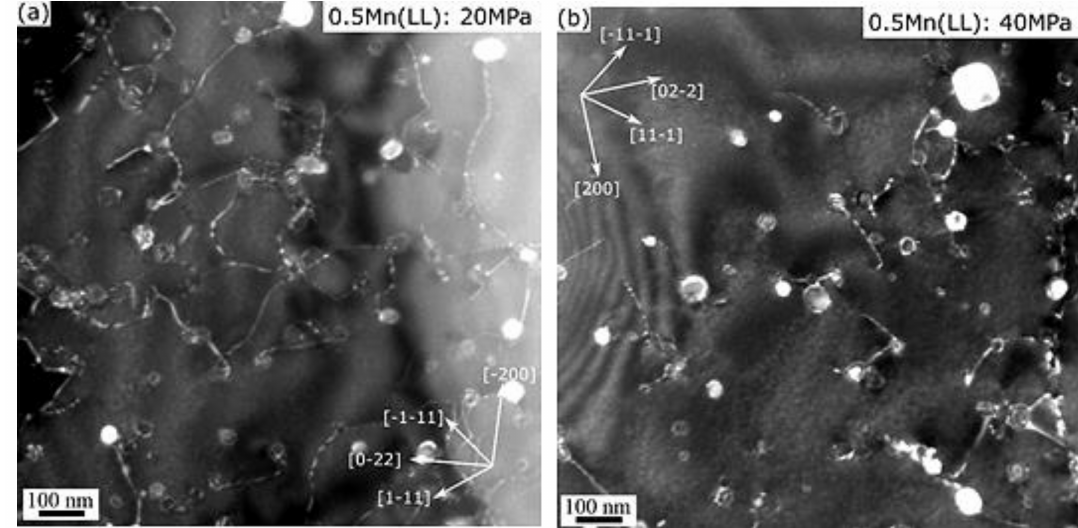
Figure 10. Weak-beam dark-field TEM images showing the interaction between dislocations and Al(FeMn)Si dispersoids in 0.5Mn(LL) creep samples under applied stresses of ( a ) 20 MPa and ( b ) 40